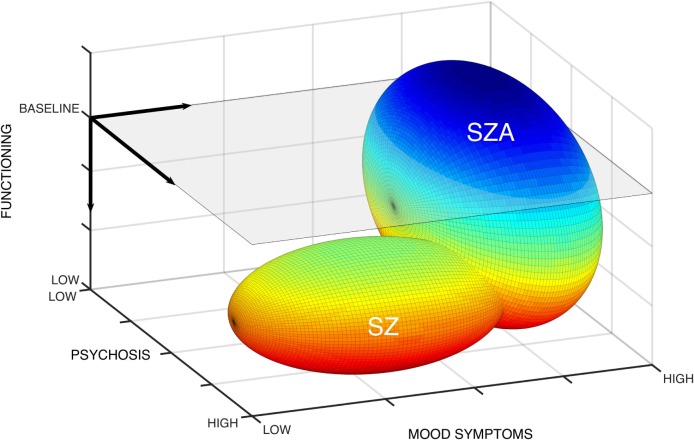
Domains of psychopathology for schizophrenia and schizoaffective disorder. The symptom space for schizophrenia and schizoaffective disorder is defined by three domains: psychosis, mood symptoms, and functioning. Gray plane indicates baseline functional status. Heat map with hotter colors indicates worsening functional impairments. Ellipsoids demonstrate that schizophrenia occupies a constrained symptom space low on functioning, high on psychosis, and lower mood symptoms. By contrast, schizoaffective disorder is less constrained with potential for greater heterogeneity in functional status and degree of psychosis, though high on mood symptoms.